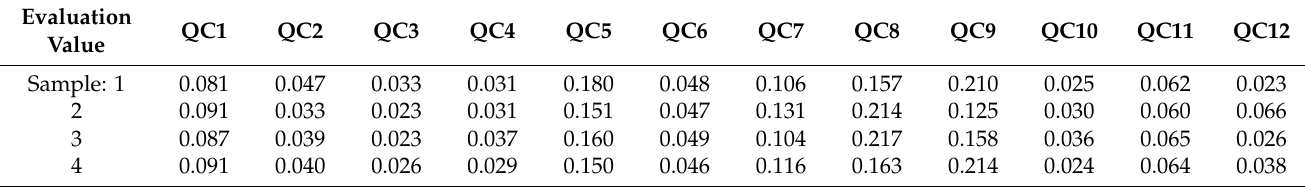
Table A1. Product QCs evaluation